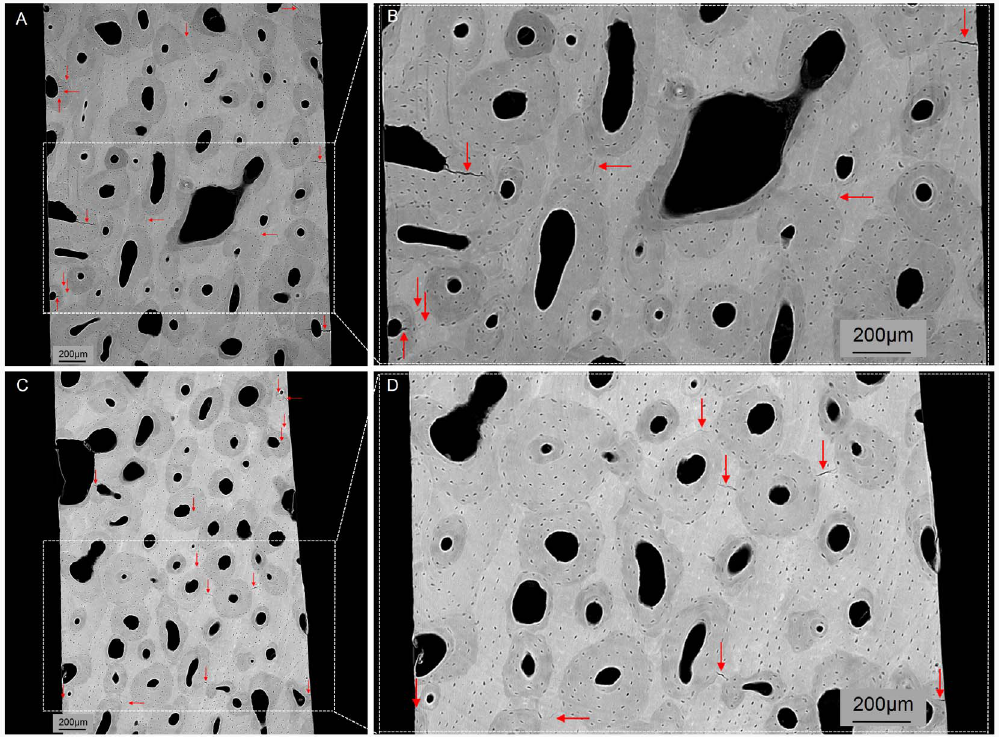
Figure 5. Example of a 2-D transverse cross-section extracted from the (A-B) unloaded region (VOI1) and (C-D) loaded region (VOI2) of the specimen # 13. Red arrows point microcracks. Figures B and D are a zoom of the figures A and C respectively.